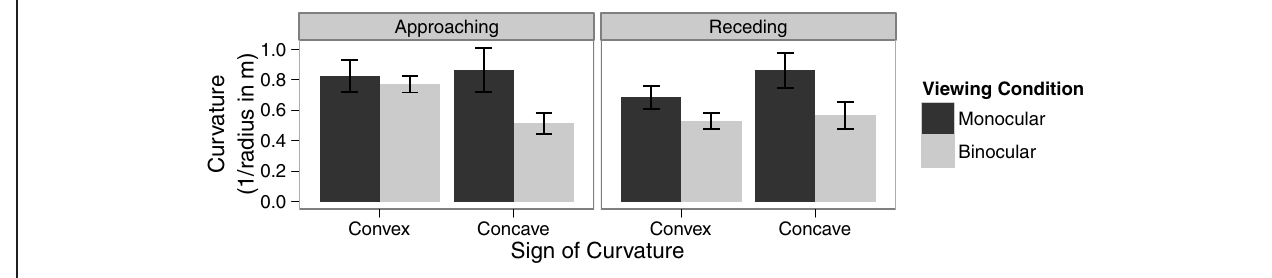
FIGURE 3 | Means in each condition with error bars representing ± 1 between-subjects standard error of the mean.